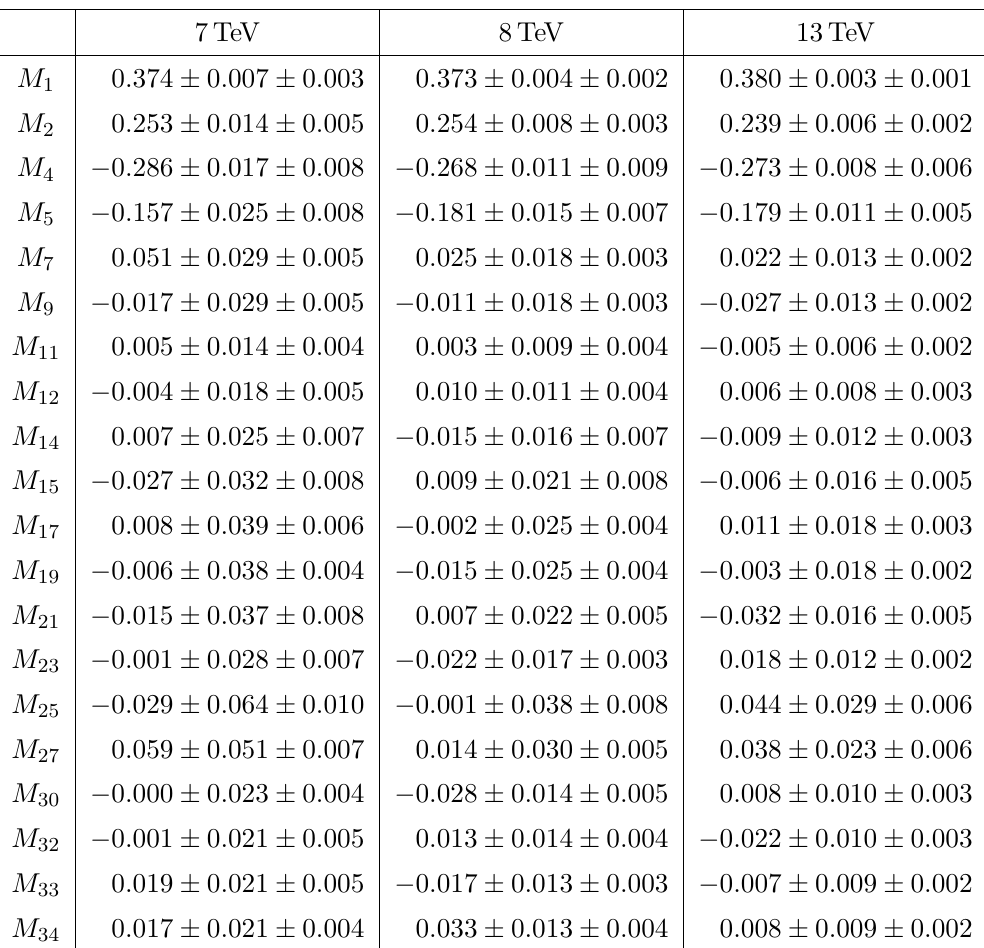
Table 3 . Values of the 20 moments, M i , measured in the data collected at 7, 8 and 13 TeV centre- of-mass energies. The long and downstream categories have been combined. The (cid:12)rst and second uncertainties are statistical and systematic,